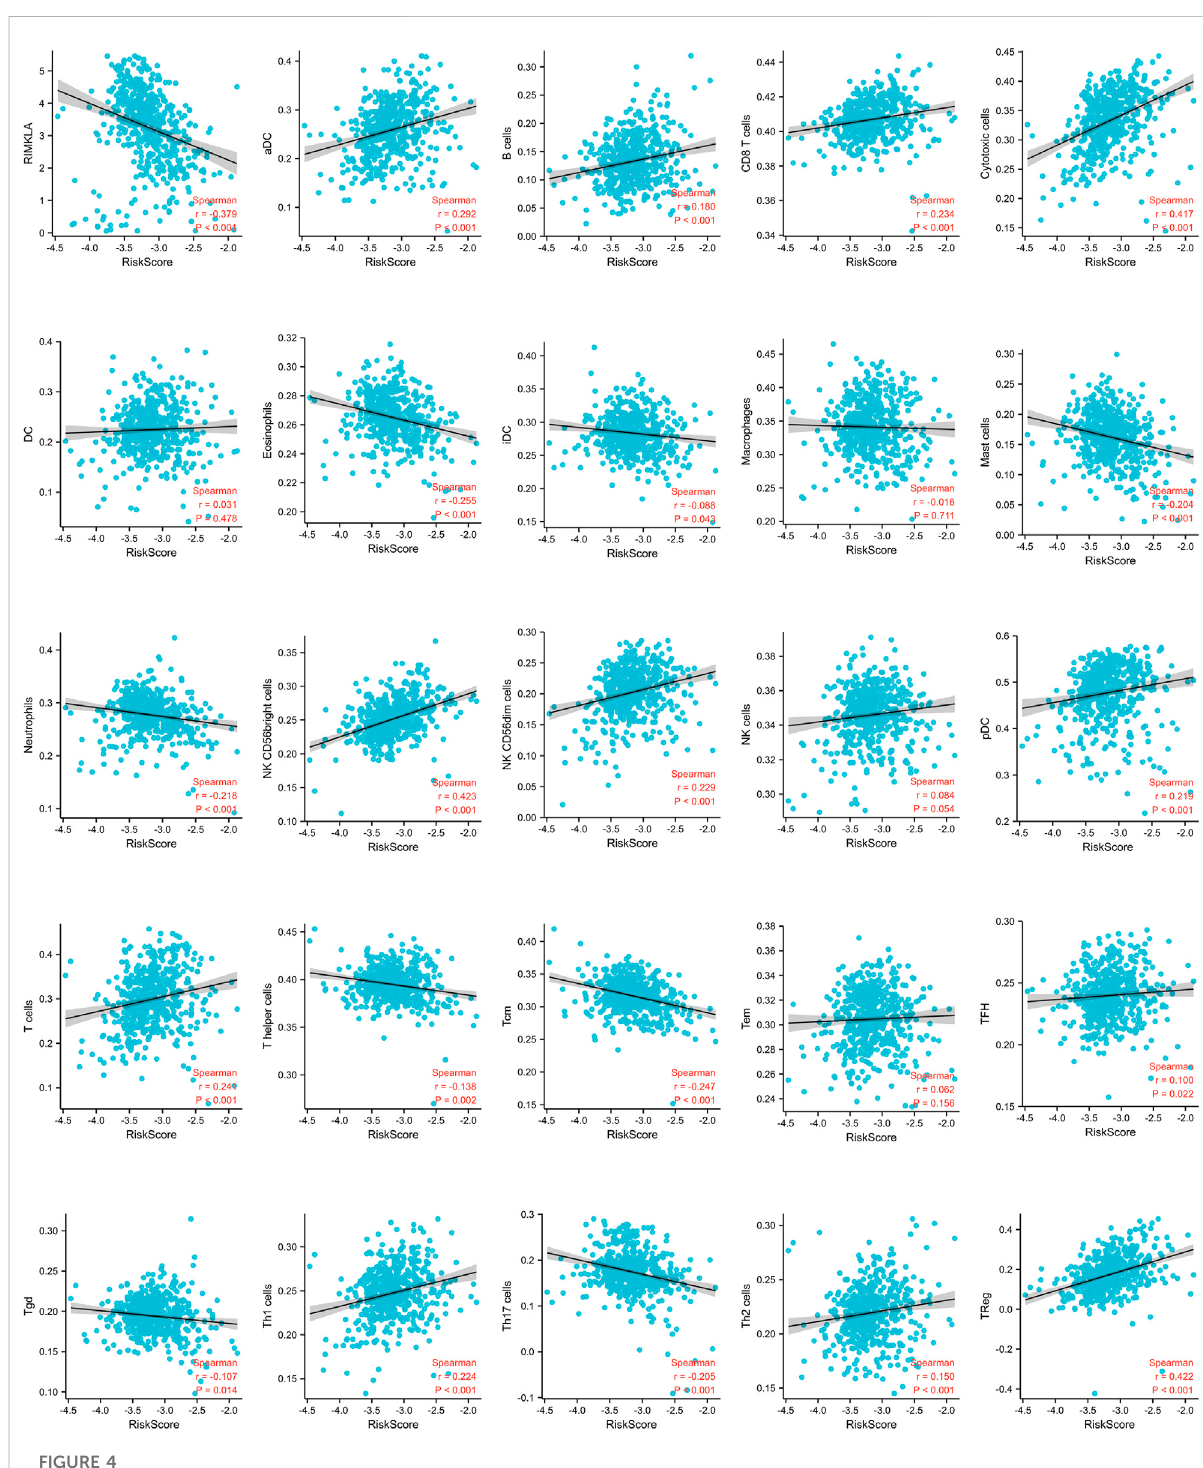
FIGURE 4 Correlation of immune cell in fi ltrates with the signature risk